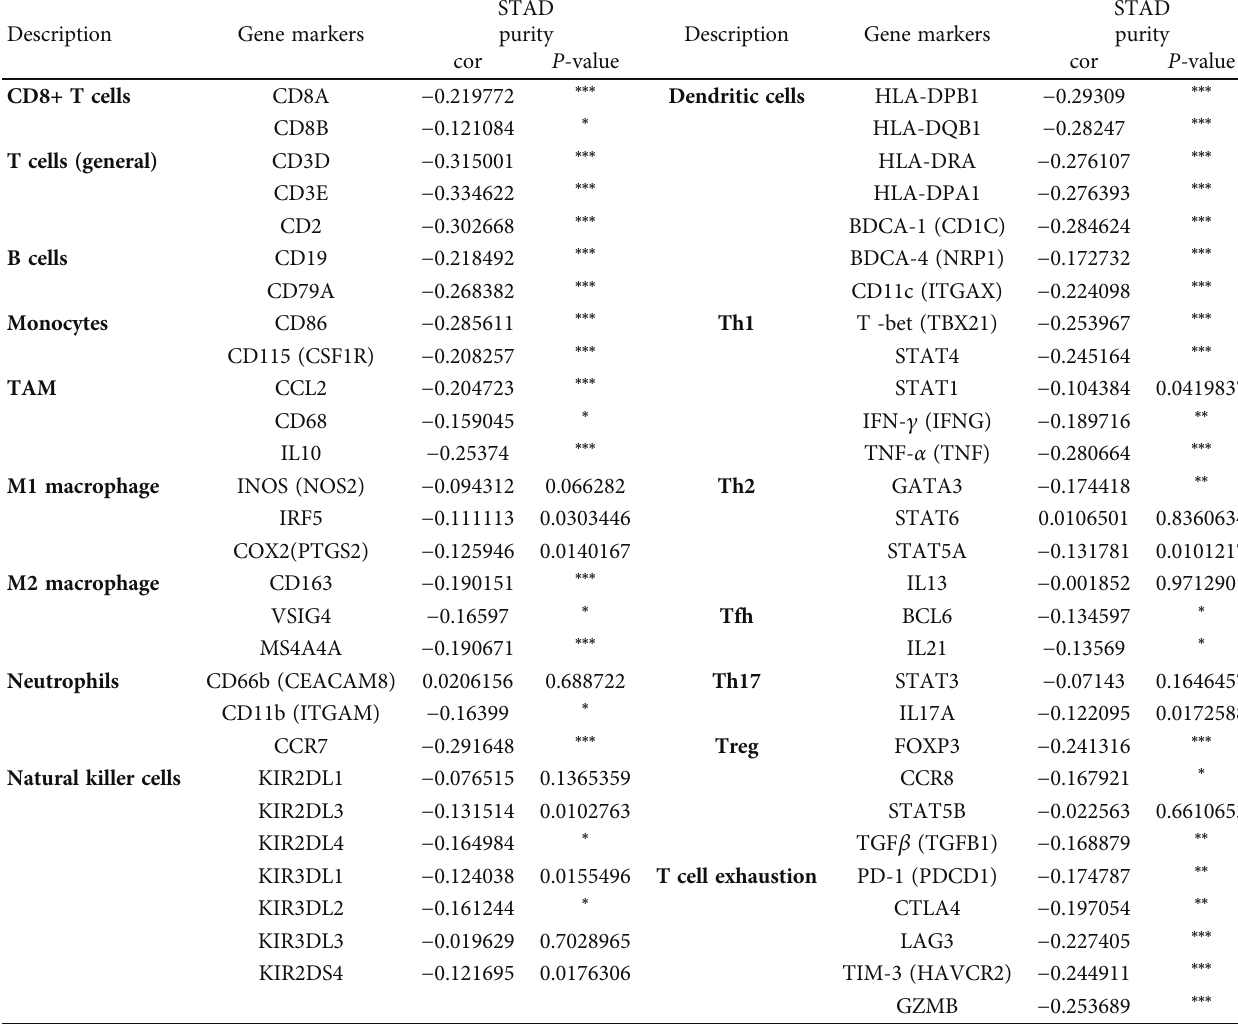
Table 3: The correlation analysis between ZNF521 and relate genes and markers of immune cells in TIMER.